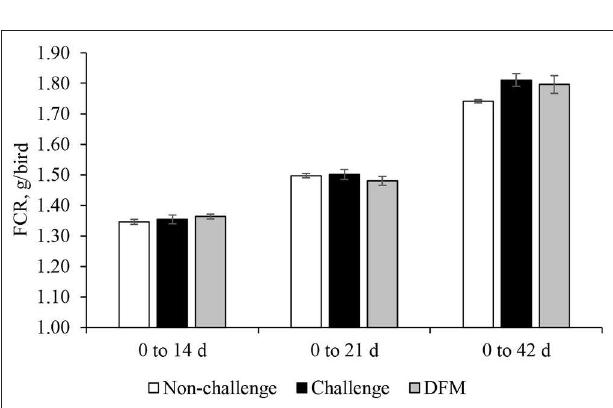
FIGURE 3 | Feed conversion ratio (FCR) of broiler chickens fed control and treatment diets. Each bar represents the mean ± SE ( n = 7).